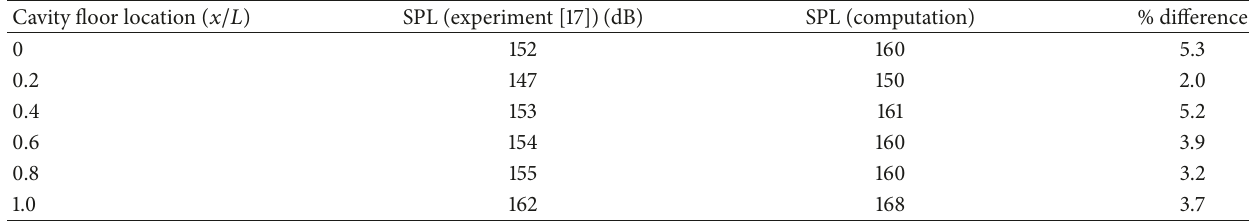
Table 5: Comparison of computations and experiments for cavity floor sound pressure